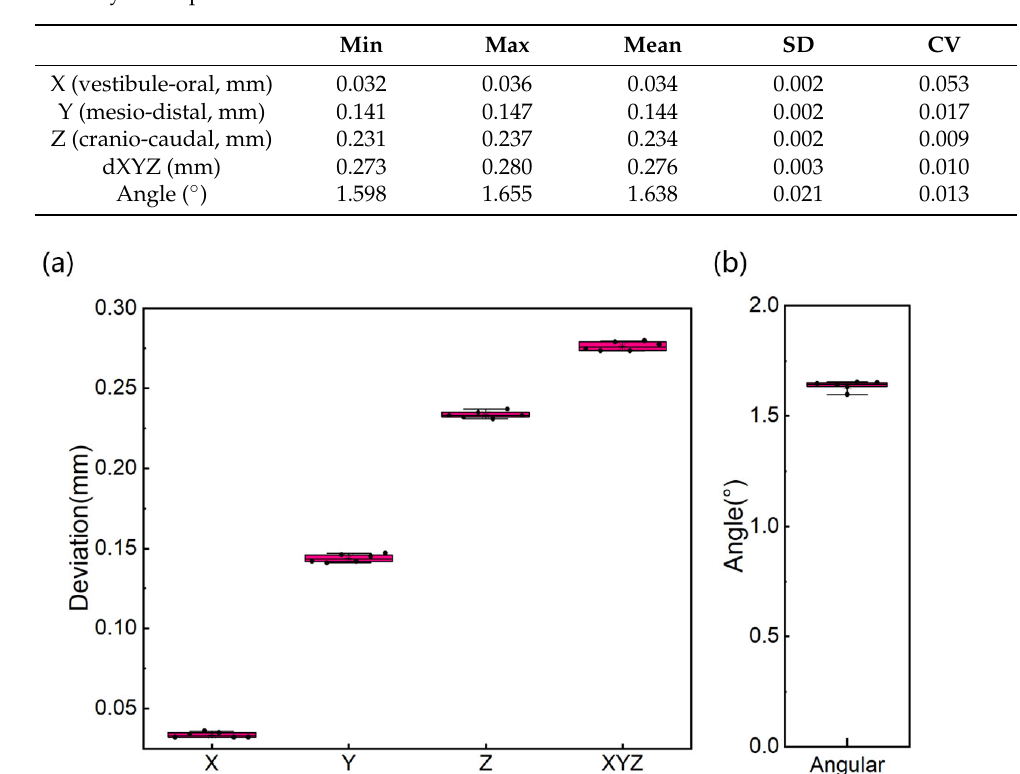
Table 2. Mean, SD (standard deviation), CV (coefficient of variation) in all dimensions and angular accuracy of 6 repeated measurements from the same case.